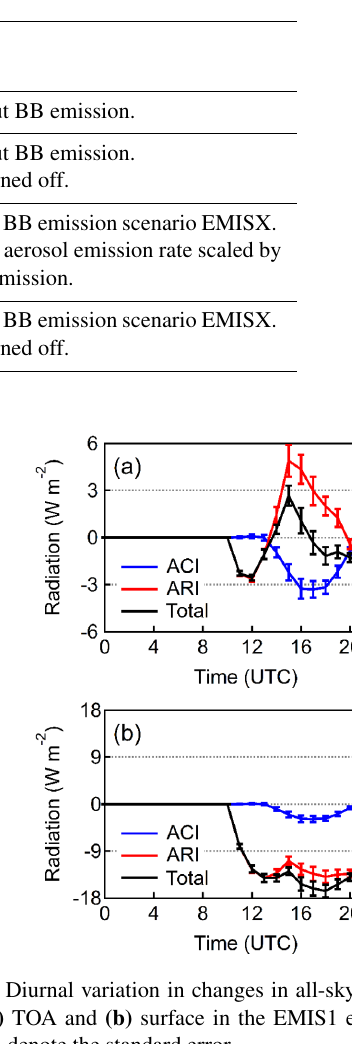
Table 2. Experiment design description.